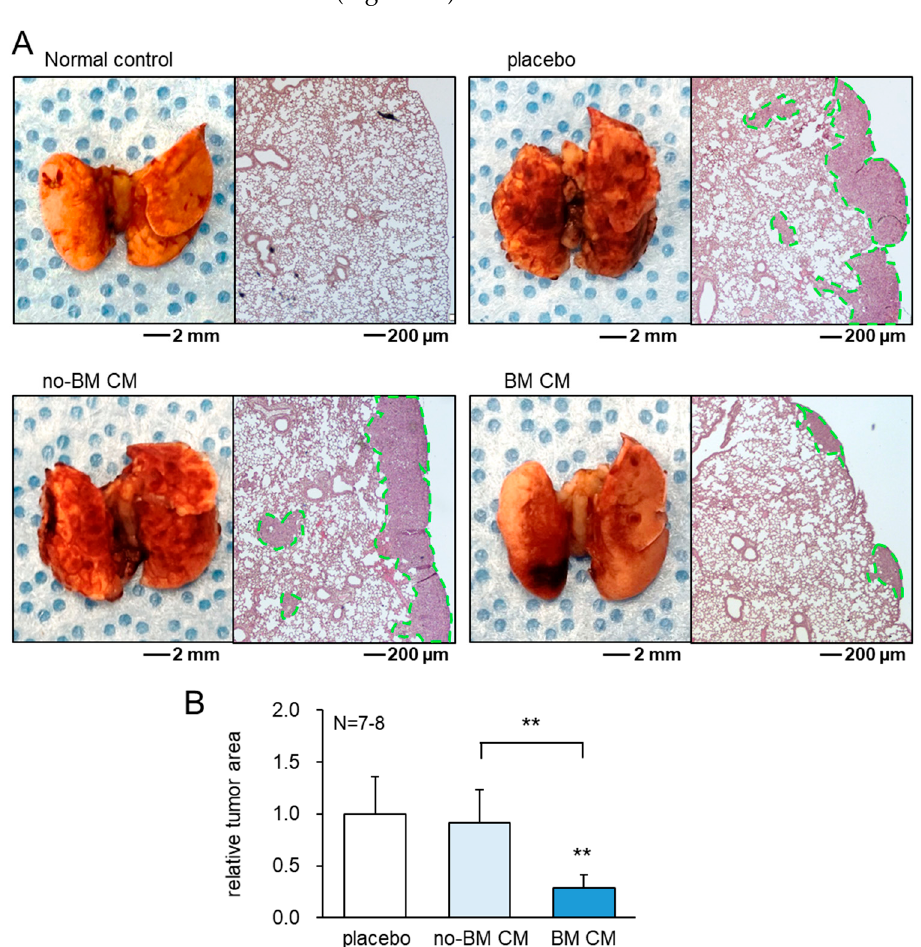
Figure 5. Protection of the lung from tumor invasion and colonization by BM CM. The lungs of C57BL/6 mice were evaluated 3 weeks after tumor inoculation as an intra-cardiac injection. no-BM CM = RAW-derived conditioned medium treated without BML284, and BM CM = BML284-treated RAW-derived conditioned medium. ** p < 0.01. ( A ) Comparison among the normal control, placebo, daily administration of no-BM CM, and daily administration of BM CM. The left images are the external appearance, while the right images are H&E stained cross-sections. ( B ) Relative tumor area.